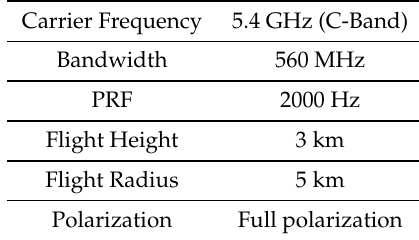
Table 1. Acquisition Characteristics.